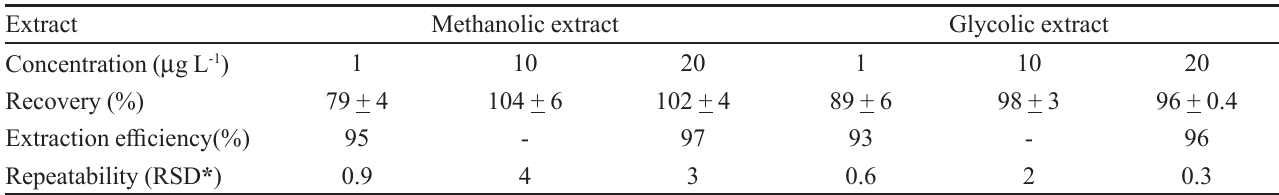
*Estimative of the absolute standard deviation TABLE III - Recovery, extraction efficiency and repeatability of the method